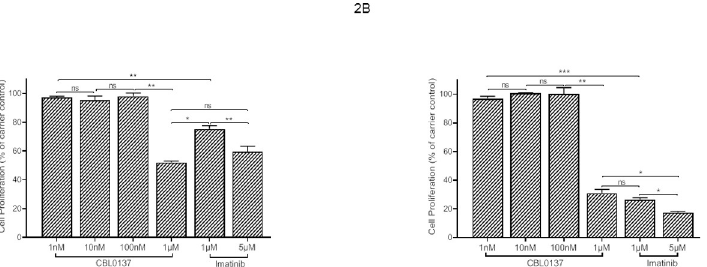
Fig 2. CBL0137 inhibits proliferation of BCR/ABL expressing cells. 2x10 3 K562 cells were seeded in triplicate in 100 μ l in a 96 well plate and the effect of a range of concentrations of CBL0137 or 1 μ M and 5 μ M Imatinib on the proliferation assessed at 24 (Fig 2A) and 48 hours (Fig 2B) using a WST-1 assay (Roche Diagnostics). Results are expressed as a percentage absorbance of the carrier control and are the mean+/-SEM n = 3. The results of a t-test are shown; ns not significant, � < 0.05, �� < 0.01, ��� <